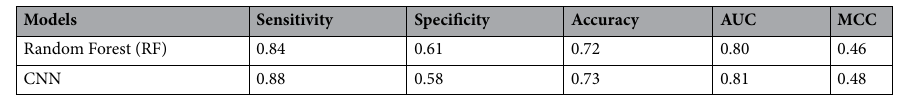
Table 5. Performance metrics of different models applying manually extracted features using an independent test dataset for S and T.